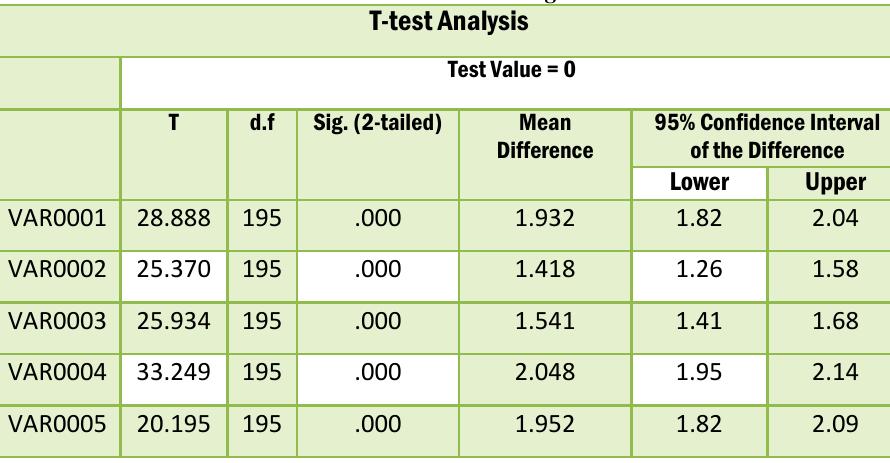
Table 5: Factors Influencing the Interface of Public Servants and Political Office Holders in Southwest